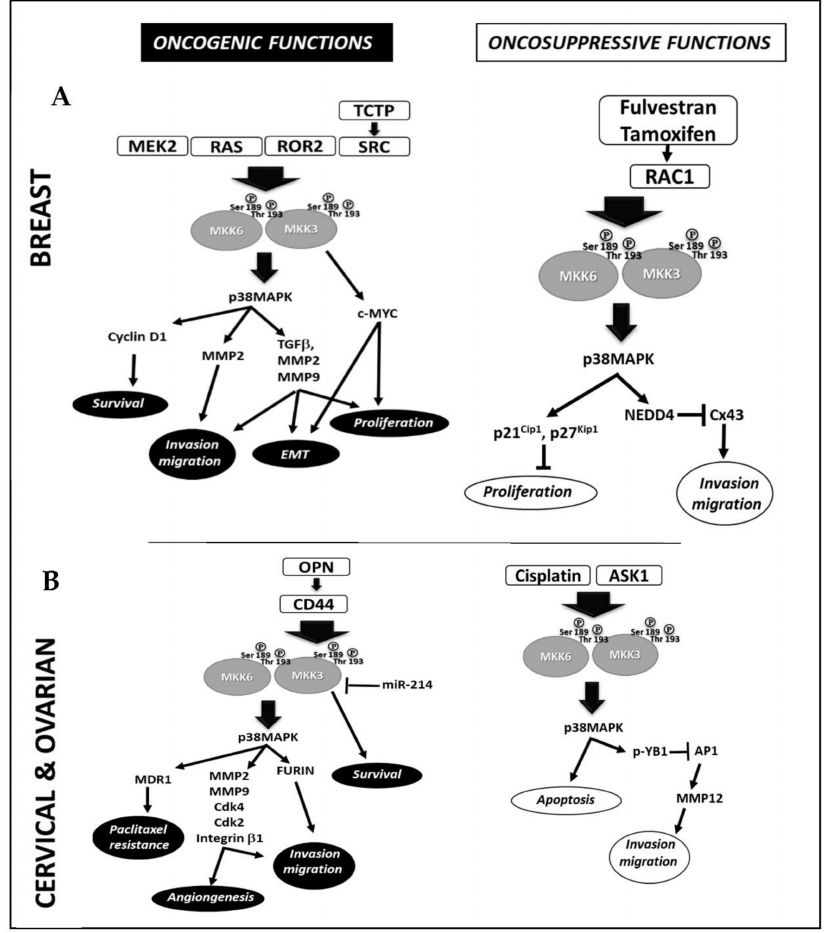
Figure 1. Molecular mechanisms involved in MKK3 oncogenic and tumor-suppressive functions in Breast ( A ) and Cervical and Ovarian cancer ( B